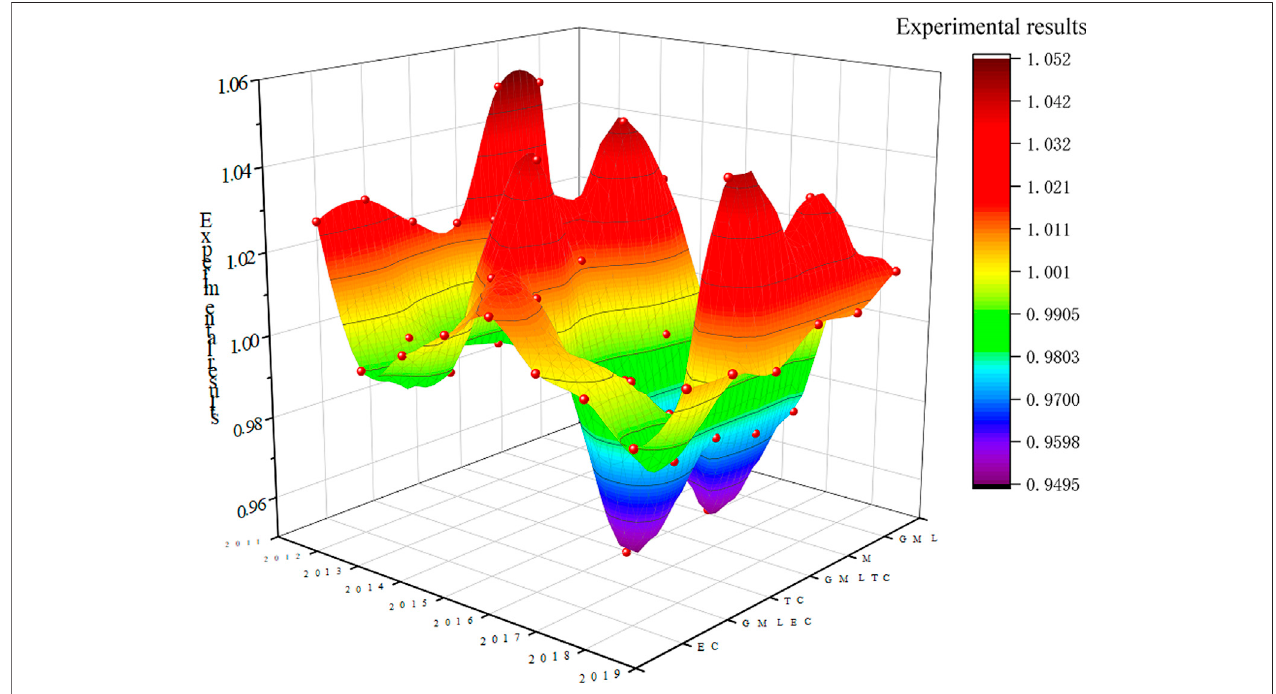
FIGURE 2 | Overall experimental results of the total factor productivity index and the green total factor productivity